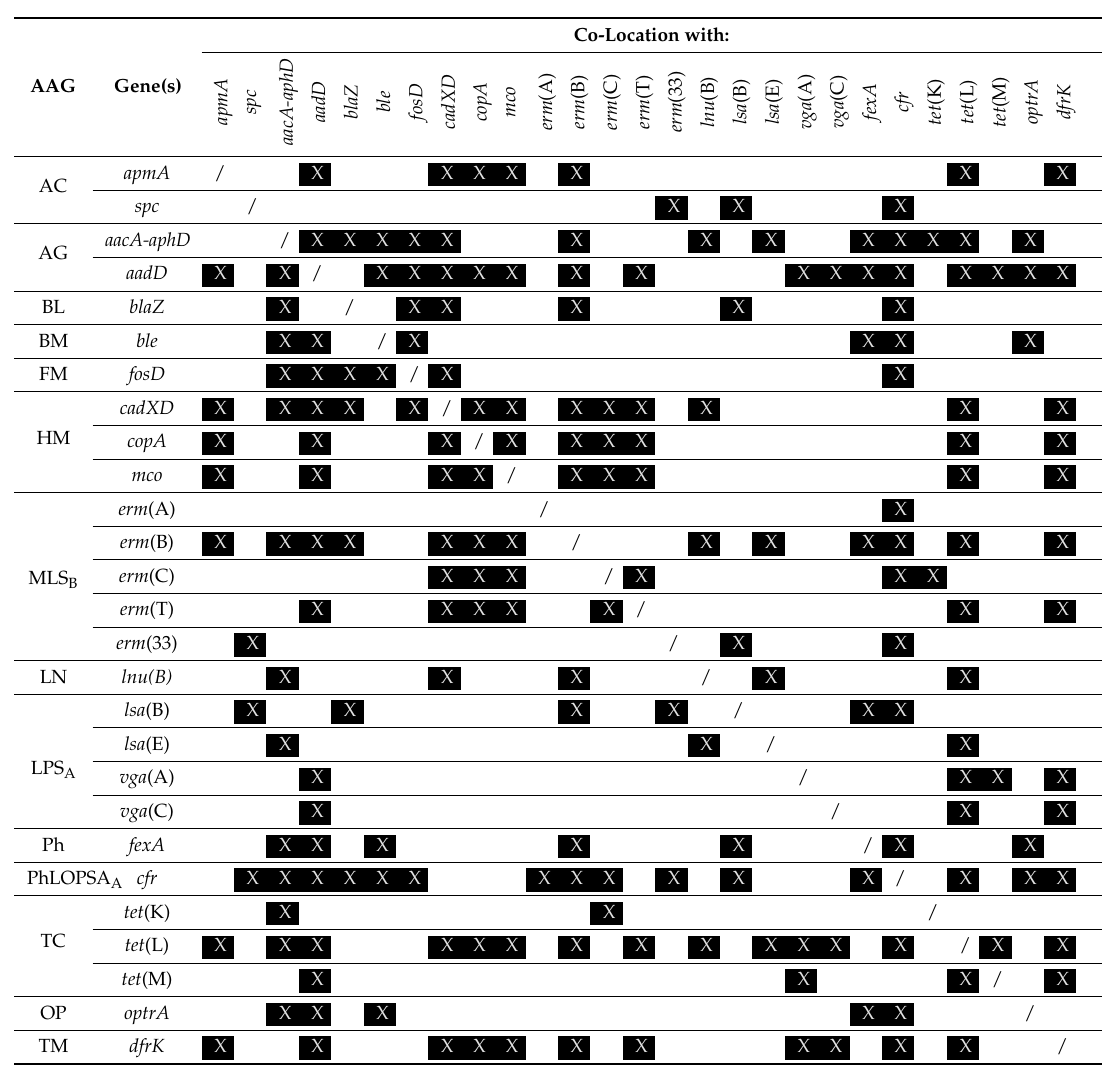
Table 5. Examples of resistance genes co-located on plasmids from